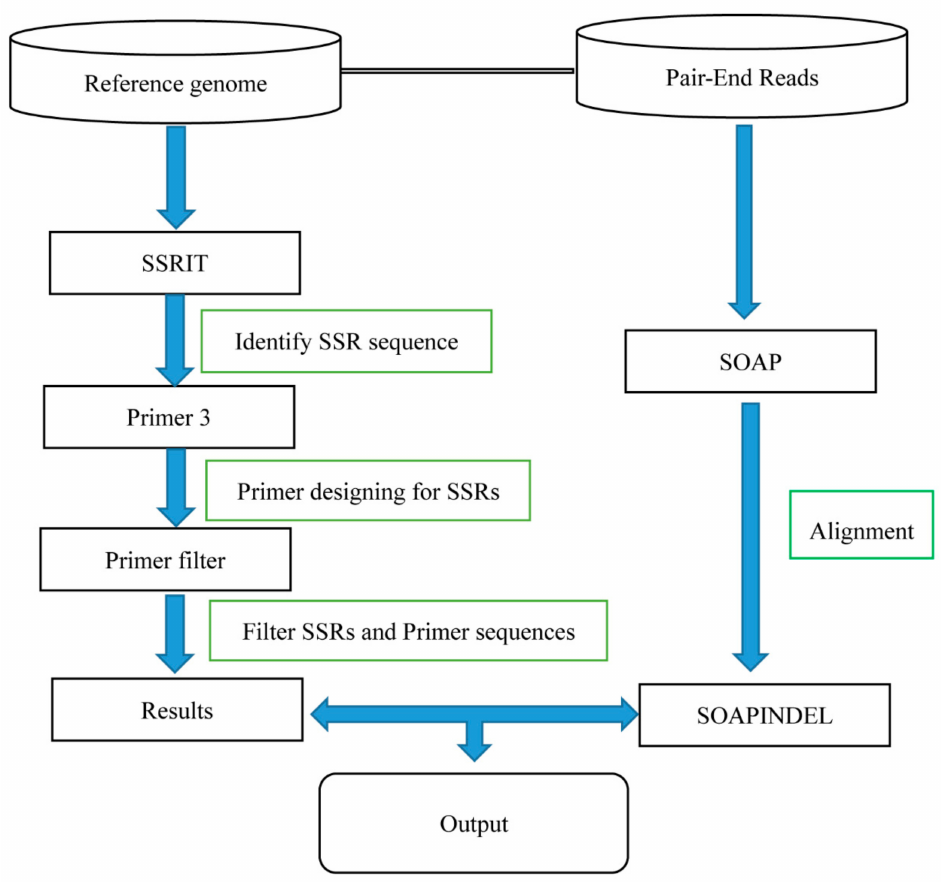
Figure 2. Flowchart of the insertion / deletion SSR (IDSSR)